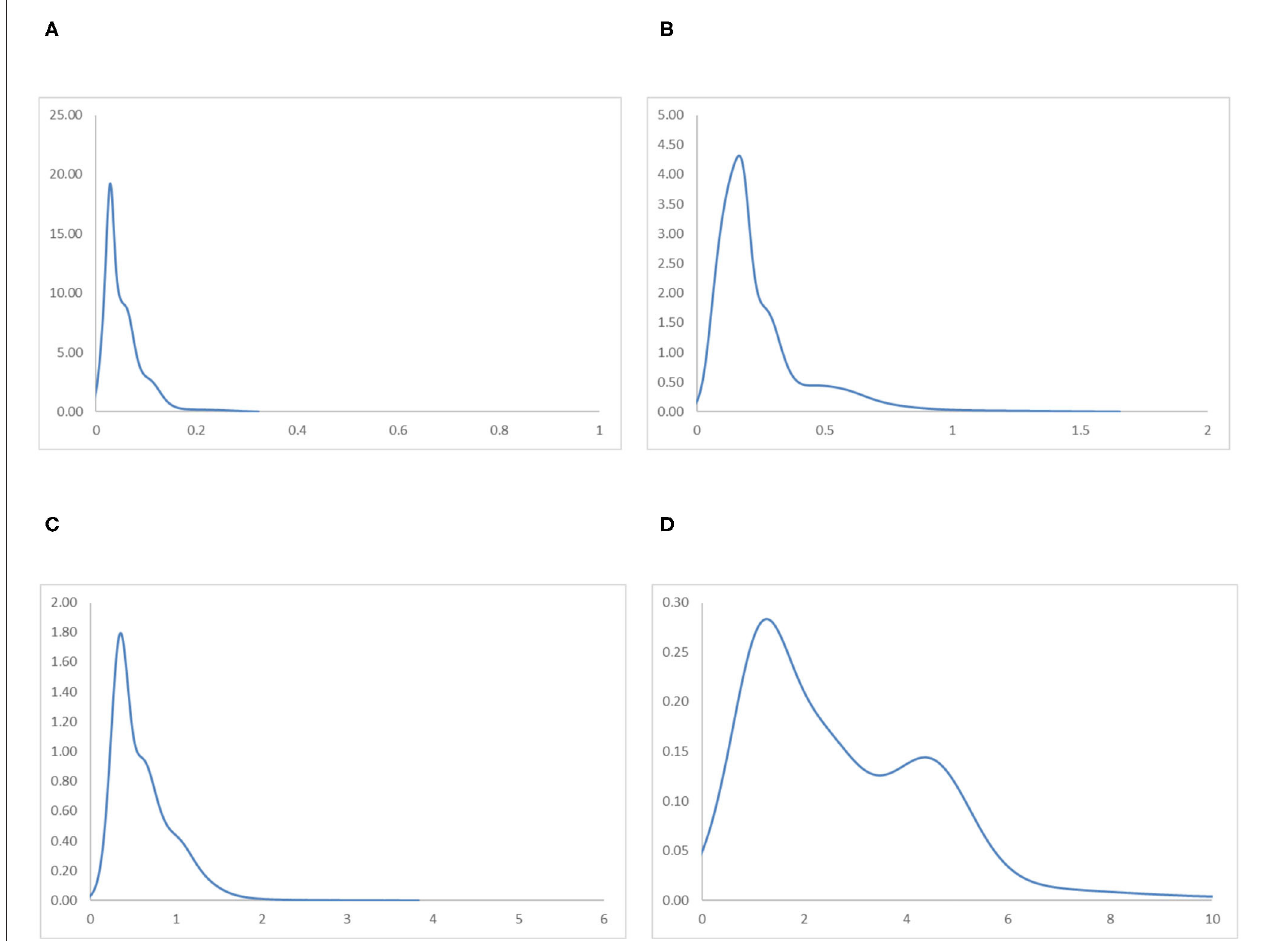
FIGURE 9 | Ergodic distributions for the RIVAPC of countries for different income groups of countries with annual transitions. Source: authors’ calculation. N.B. The vertical axis indicates the density of probability and the horizontal axis indicates RIVAPC values. (A) Low-Income Countries. (B) Lower-Middle Income Countries. (C) Upper-Middle Income Countries. (D) High-Income